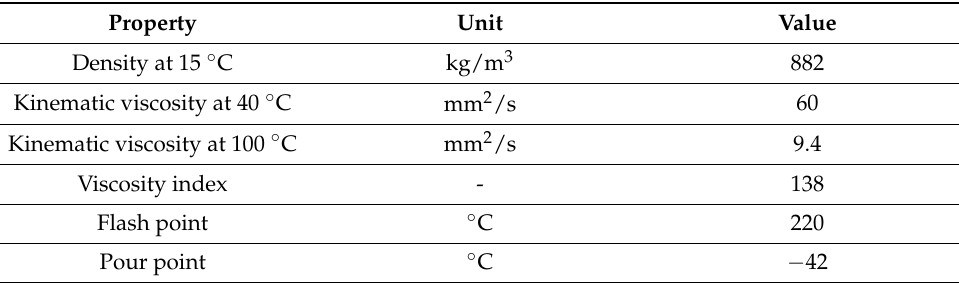
Table 2. Lubricant’s